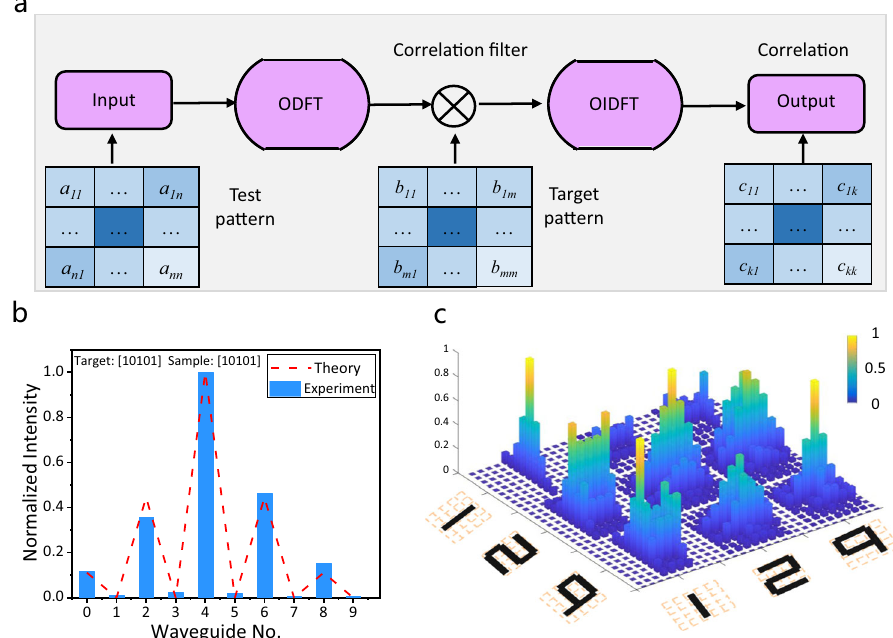
Fig. 3 Image recognition. a Schematics of the image recognition process. The input test image dimension is n × n , target image dimension is m × m and the output dimension is k = n + m - 1. b Experimental normalized intensity from the output waveguides when the sample sequence [10101] is the same as the target sequence [10101]. c Experimental correlation results for digit image recognition. There are three-digit images (1, 2, 9), and each digit image is composed of 5 × 5